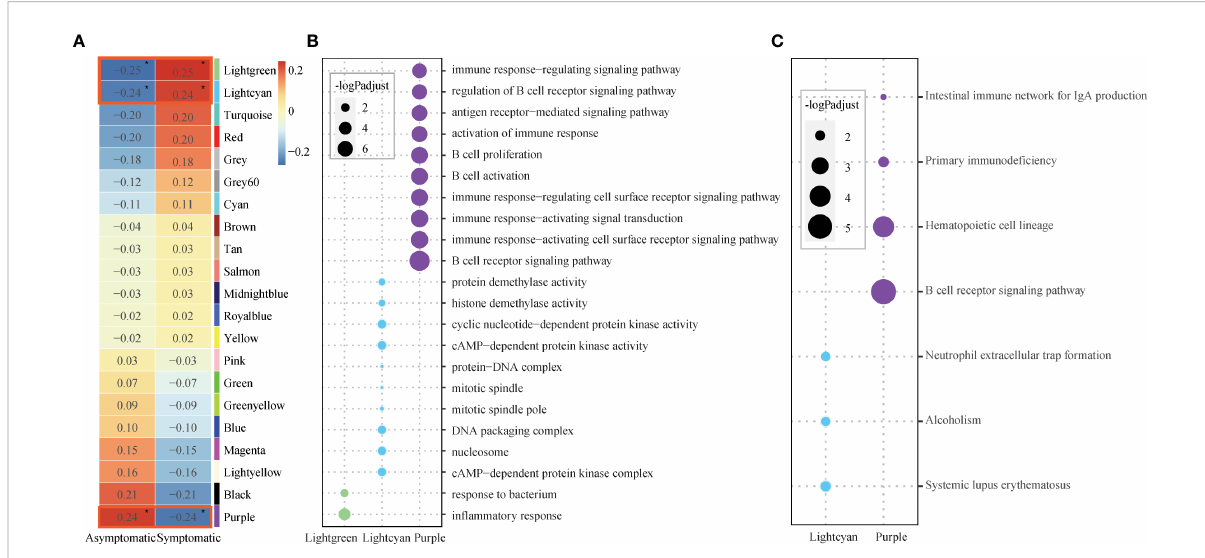
FIGURE 2 Core modules and their enriched functions. (A) Heatmap of Module-trait ’ s correlation, in which traits on the x-axis against the co-expression modules on the y-axis. The corresponding correlation was shown in the cells and color coded. The signi fi cantly related modules with the signi fi cant level were indicated by number of asterisks (* for p ≤ 0.1) and highlighted by red rectangles. (B) Bubble chart displaying the GO terms enriched for the three signi fi cant modules (Lightgreen, Lightcyan, Purple). Dot sizes are scaled to the enrichment signi fi cance. Different colors represent different modules. (C) Bubble chart displaying the KEGG pathways enriched for the two signi fi cant modules (Lightcyan, Purple). Dot sizes are scaled to the enrichment signi fi cance. Different colors represent different